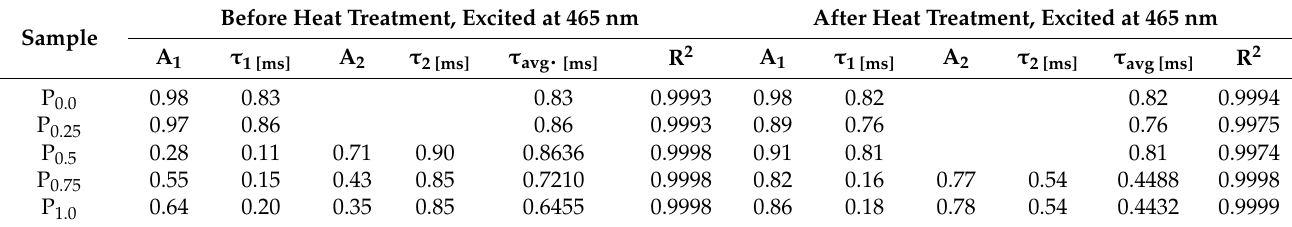
Table 5. Lifetime of 5 D 0 level at excitation of 465